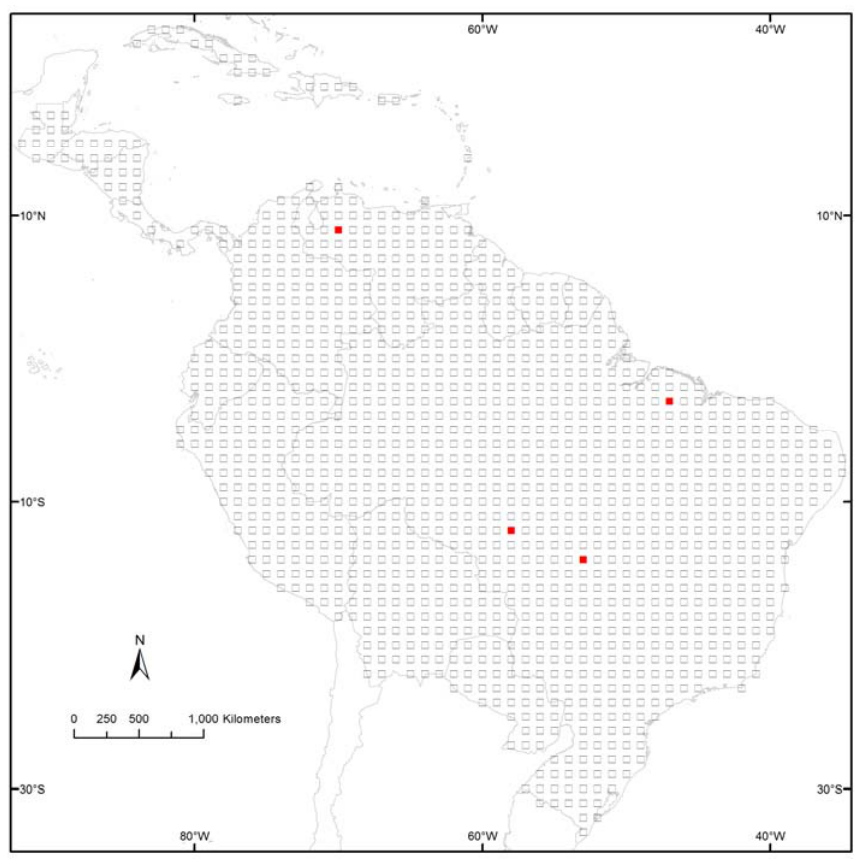
Figure 1. The study area with the location of the 1,230 sample sites. The location of the sites shown in Figure 2 are shown in